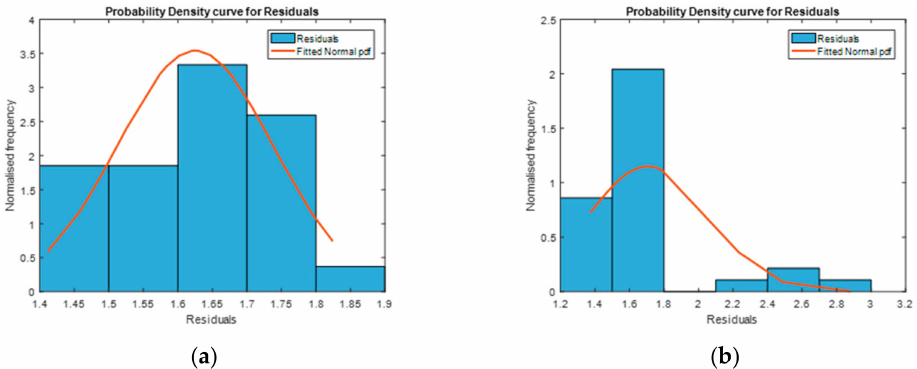
Figure 2. Histogram for Residuals: ( a ) without Run-outs; ( b ) with Run-outs.